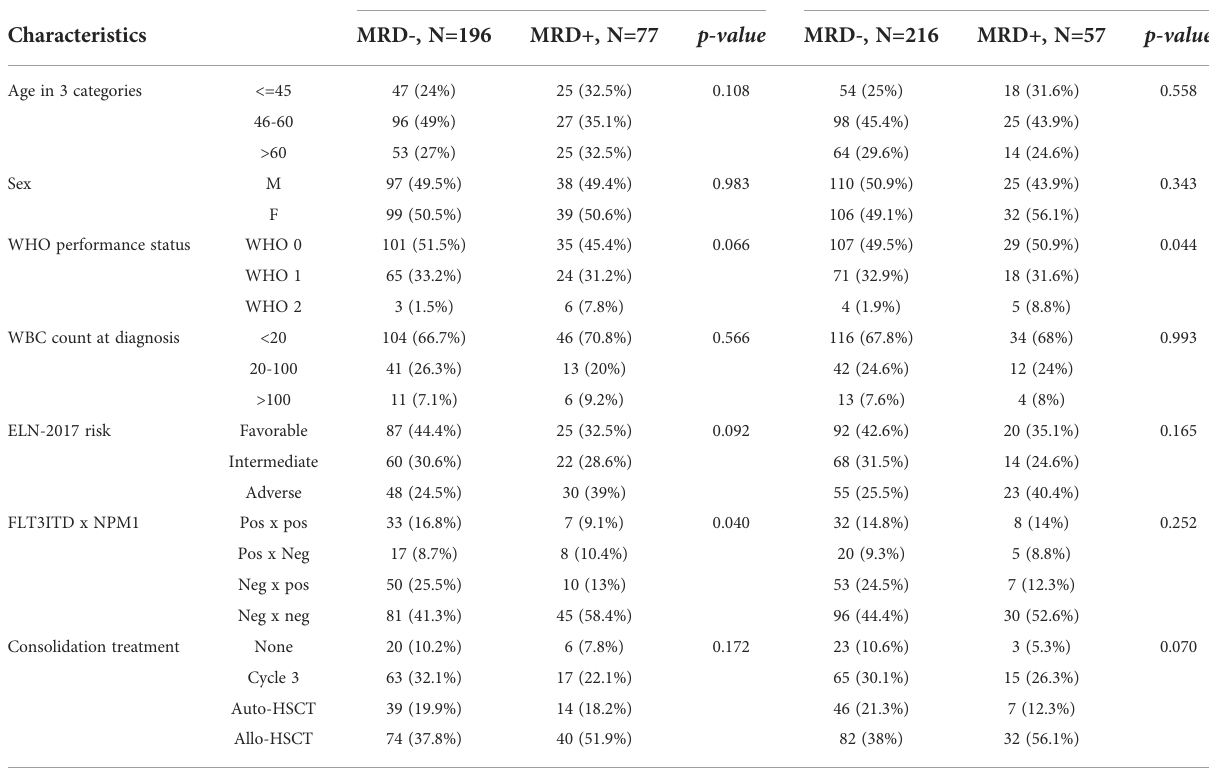
MRD status after cycle 1 MRD status after cycle 2